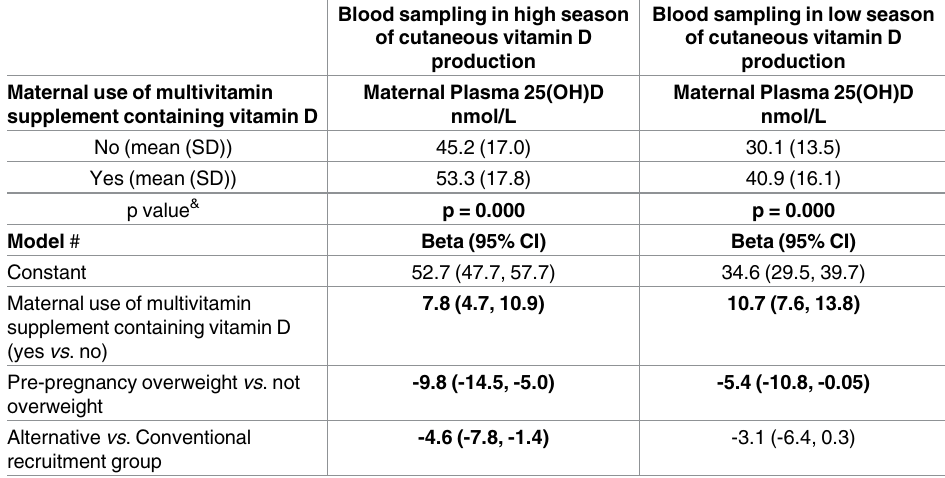
Table 2. Mean maternal 25(OH)D concentration according to season of blood sampling and use of multivitamin supplements containing vitamin